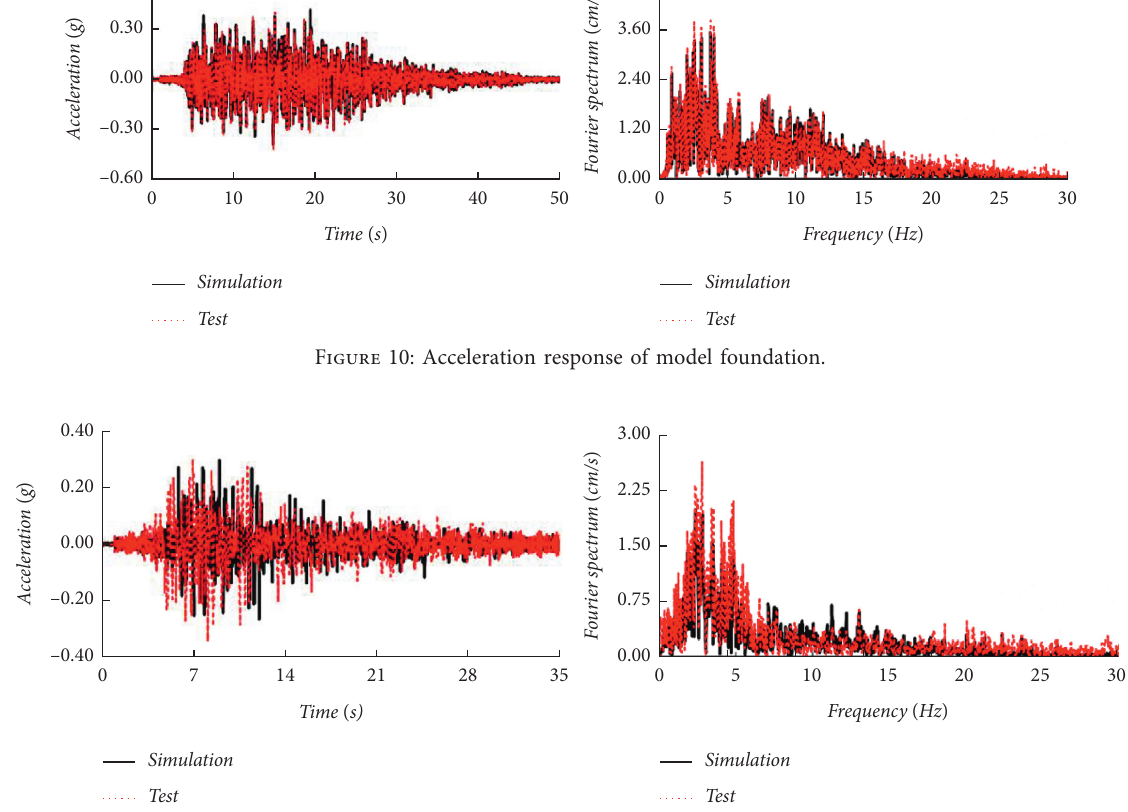
Figure 11: Acceleration response of model